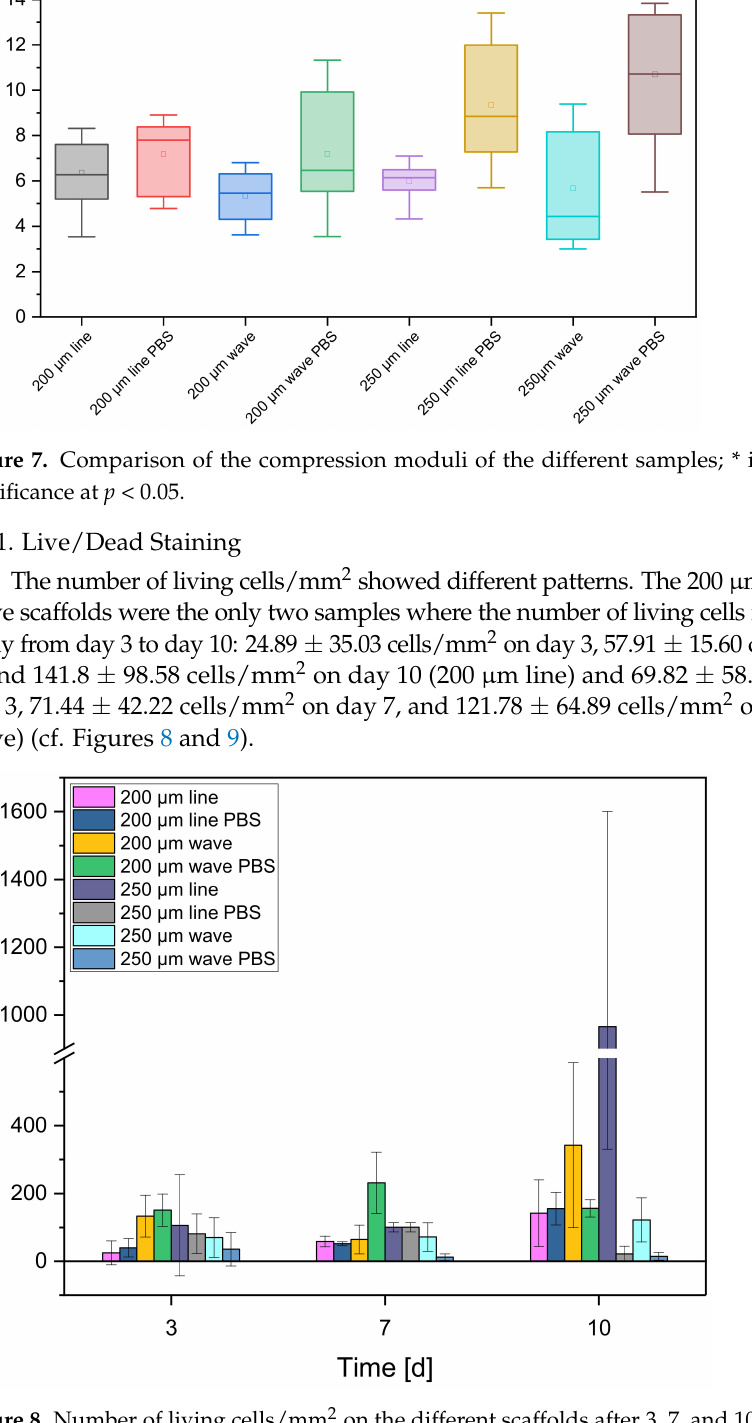
Figure 8. Number of living cells/mm 2 on the different scaffolds after 3, 7, and 10